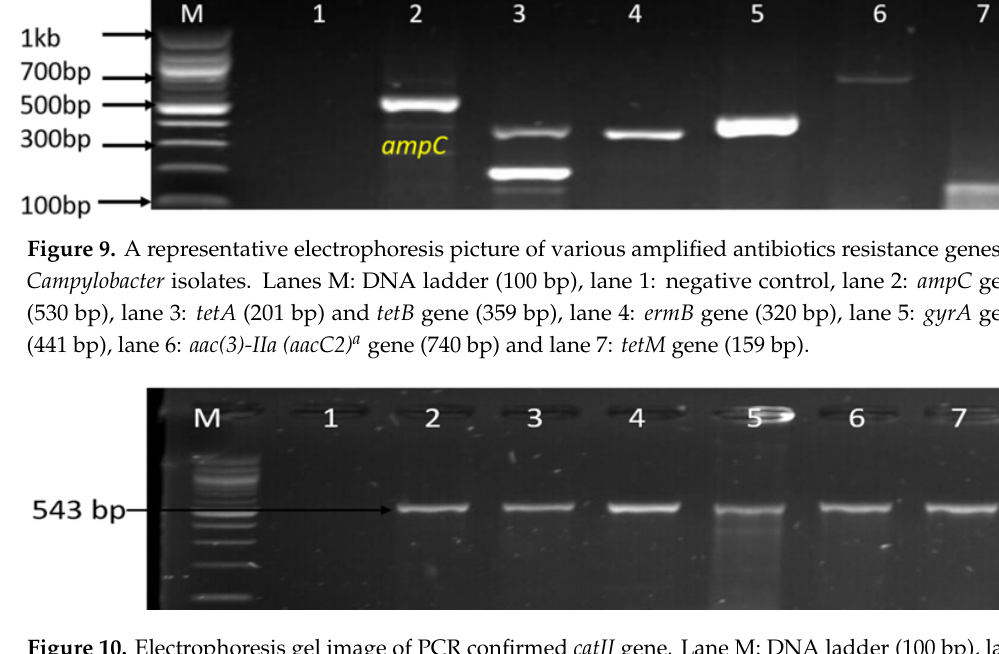
Figure 10. Electrophoresis gel image of PCR confirmed catII gene. Lane M: DNA ladder (100 bp), lane 1: negative control, lane 2–7, Campylobacter isolates that harbored the catII gene (543 bp). Table 4. Multiple antibiotic resistance genes in C . fetus , C. jejuni and C . coli isolates.